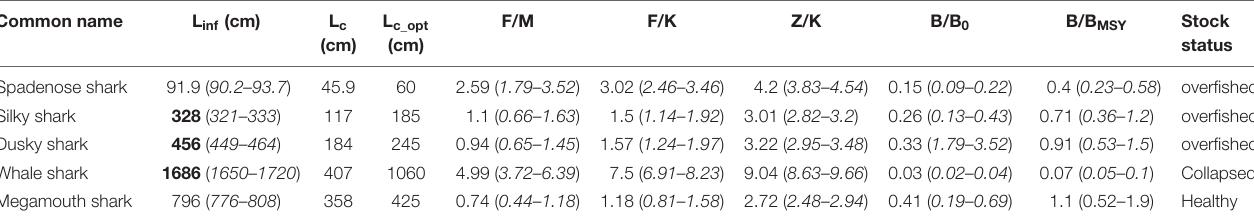
TABLE 2 | Length reference points (L inf , L c and L c_opt ), F/M, F/K, Z/K and relevant biomass (B/B 0 and B/B MSY ) and their 95% confidence intervals (italic number in brackets) of 5 sharks species estimated by the LBB